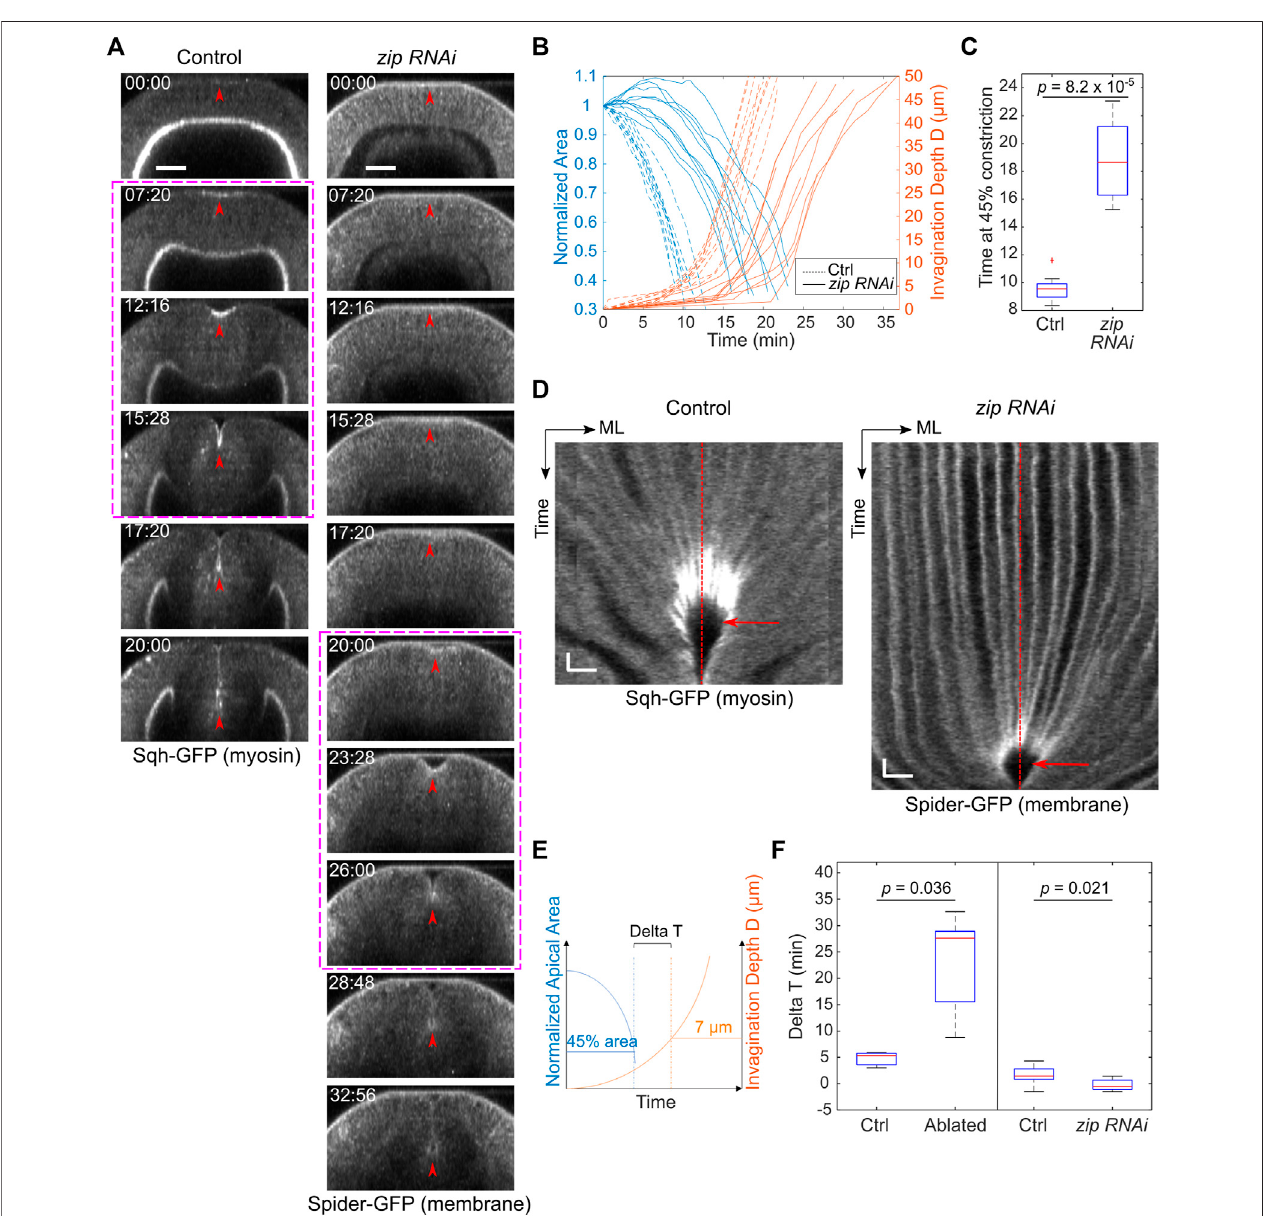
FIGURE 3 | zip RNAi embryos show reduced rate of apical constriction but not delay at T trans . (A) Cross-sections showing ventral furrow formation in a zip RNAi embryo and acontrolembryo. zip RNAi embryos show a much-reduced rate ofapical constriction, but the subsequent transition into rapidinvagination after T trans is not affected(magentaboxes).Redarrowheadsindicatetheapexoftheventralmostcells.Scalebars:25 μ m. (B) InvaginationdepthD(orangelines)andcellapicalarea(blue lines) in zip RNAi (solid) and control (dotted) embryos. Time zero represents the onset of gastrulation, which is de fi ned by the time point when obvious apical cell shape change happens at the ventral side of the embryo. Note that in some zip RNAi embryos, apical domain of the ventral cells fi rst undergoes a transient expansion before constriction starts. (C) Time when the constriction domain in zip RNAi and control embryos reaches 45% constriction. Student ’ s t-test; zip RNAi : N = 8 embryos; control: N =9embryos. (D) Kymographshowingnoobviousdelayatthetransitionalstage(redarrow)in zipRNAi embryosdespitethereducedrateofapicalconstriction. ML, medial-lateral. Red dashed lines: ventral midline. Scale bars: horizontal, 10 μ m; vertical: 80 s (E , F) Comparison of Delta T between the control ( N = 9) and zip RNAi ( N =8)embryos. zipRNAi embryosshowednoincreaseinDeltaTdespitethereducedrateofapicalconstrictionsimilartothatinembryossubjectedtolaserdisruptionof lateral ectodermal cells.Delta Tincontroland laser-treated embryosfrom Figure2 isreplotted herefor comparison. Statisticalcomparisonswereperformed usingtwo- sided Wilcoxon rank sum